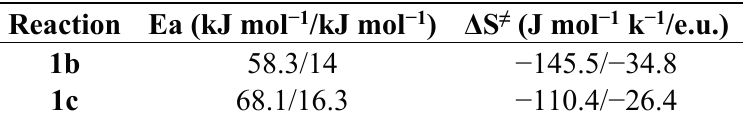
Table 9. Activation energy and entropy for isopropanolysis of sulfinamide 1b and 1c catalyzed by trifluoroacetic